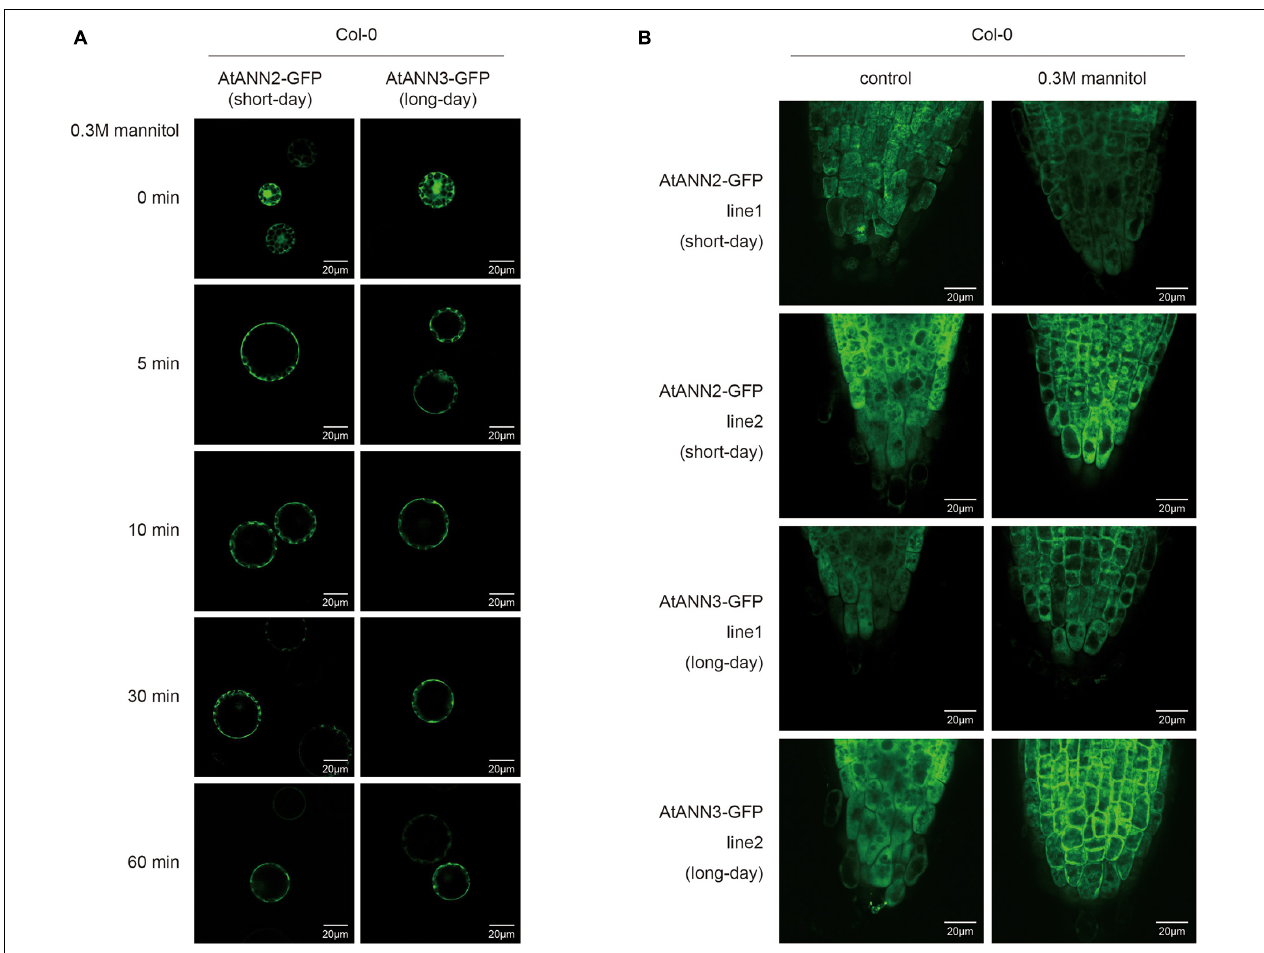
FIGURE 4 | Regulation of the subcellular localization of AtANN2 and AtANN3 in response to mannitol treatment under different photoperiods. (A) Subcellular localization of the AtANN2-GFP and AtANN3-GFP fusion proteins in response to mannitol treatment for 0, 5, 10, 30, and 60 min using leaf cell protoplasts of Col-0 plants grown under different photoperiodic conditions. Scale bar = 20 µ m. (B) Subcellular localization of AtANN2-GFP and AtANN3-GFP fusion proteins using the transgenic lines (line1 and line2). 10-day-old plants under different photoperiods were treated with 300 mM mannitol for 5 min and GFP signals were observed under a confocal laser-scanning microscope. Scale bar = 20 µ